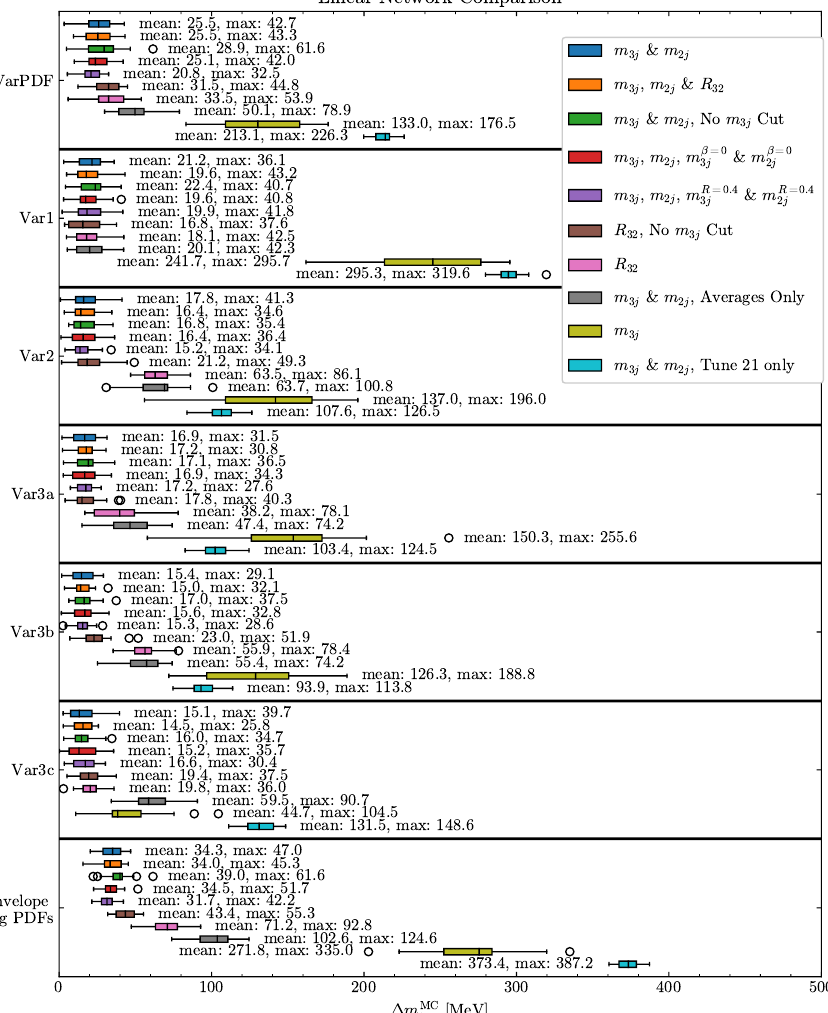
to subtracting 173 GeV from m